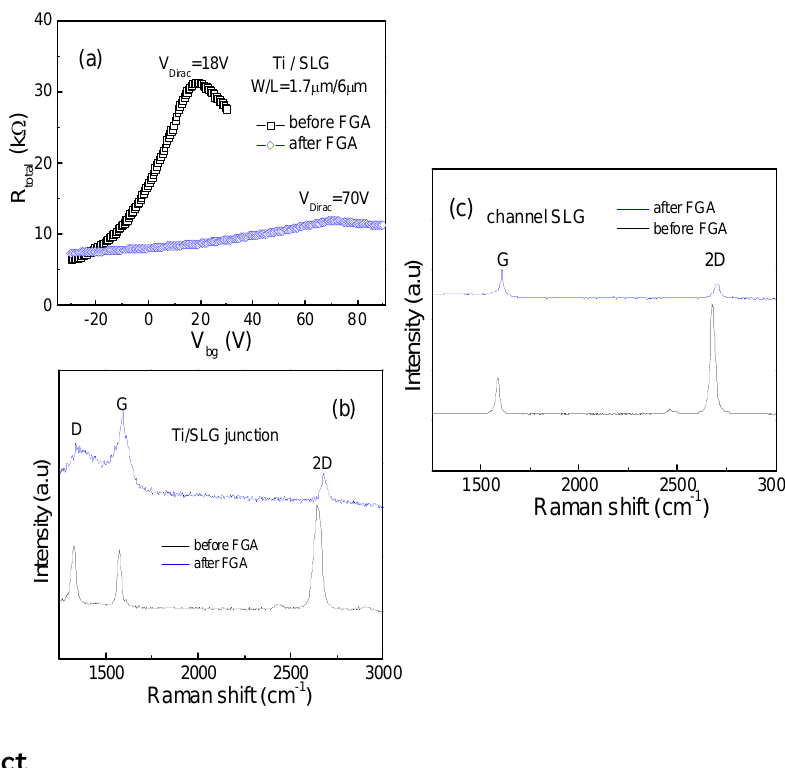
before and after forming bg of Ti/SLG; ( b ) Raman spectra c